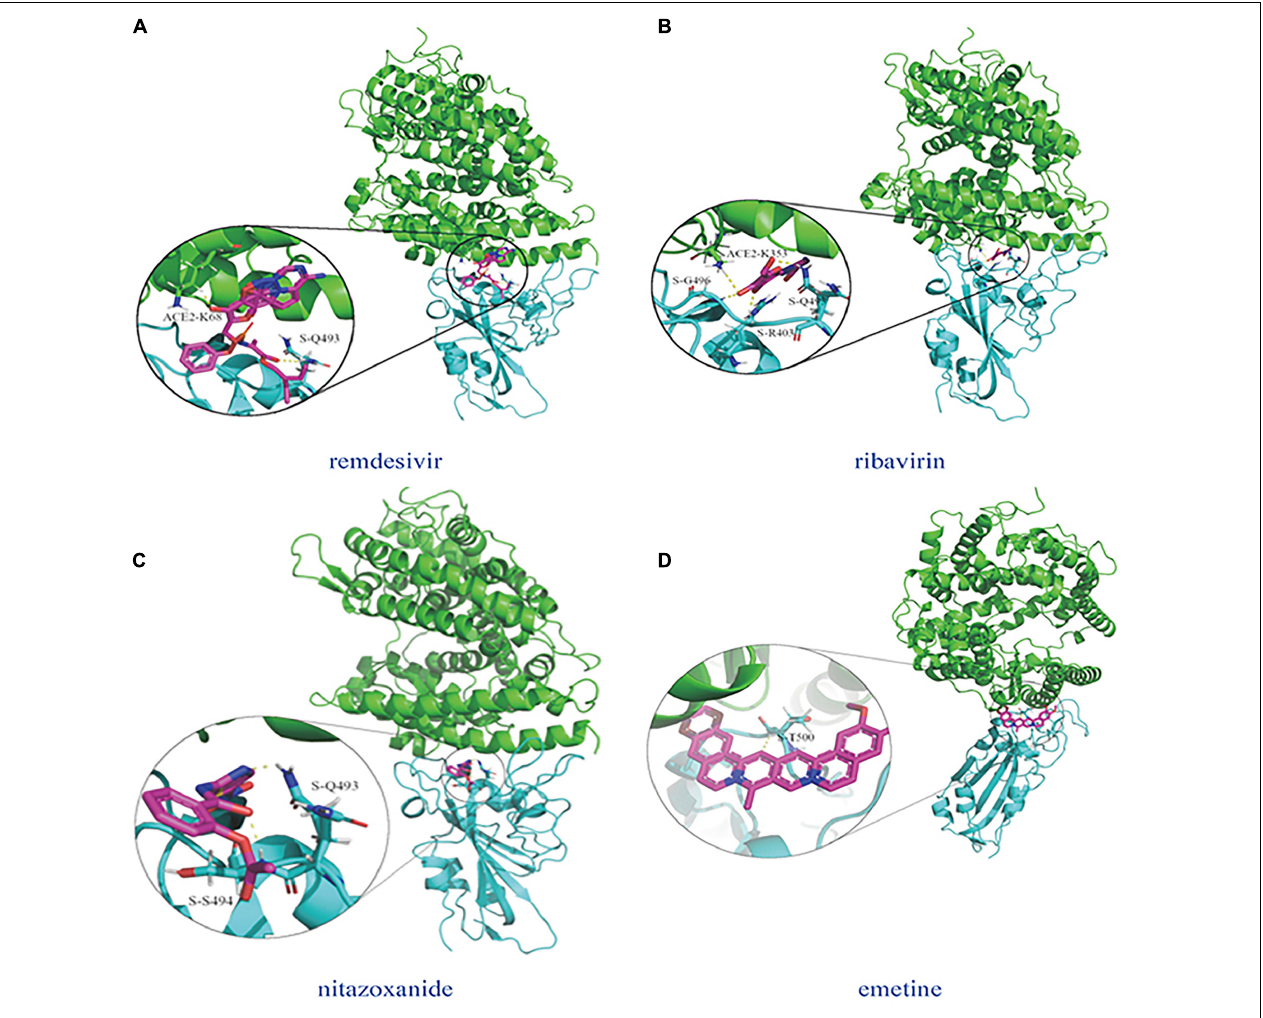
FIGURE 5 | Molecular dockings between the predicted four possible antiviral drugs against COV1D-19 (remdesivir, ribavinn, nitazoxanide, and emetine) and the junction of the S protein-ACE2 interface. (A) remdesivir (Peng et al., 2021; Wang J. et al., 2021; Shen et al., 2022), (B) ribavirin (Peng et al., 2021; Wang J. et al., 2021; Shen et al., 2022), (C) nitazoxanide, and (D)